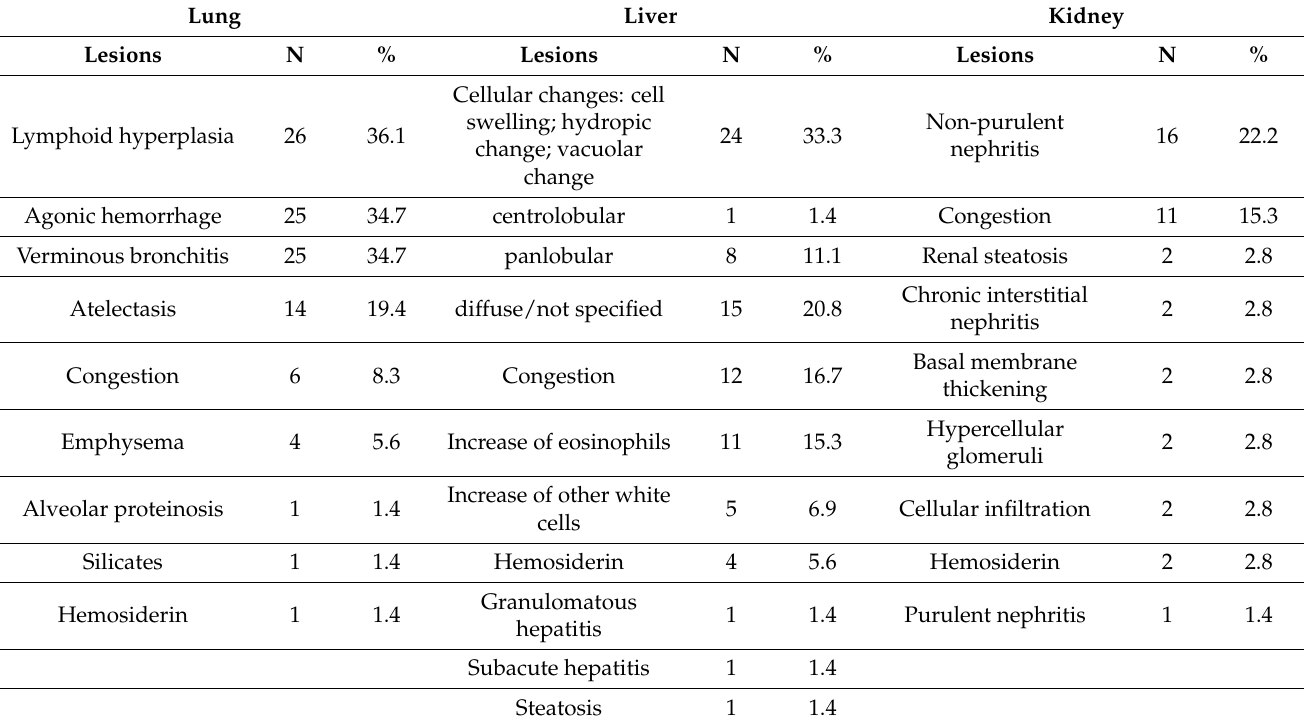
Table 1. Histopathologic lesions found in each organ (lung, liver, and kidney), as well as the number (N) and percentage (%) of animals